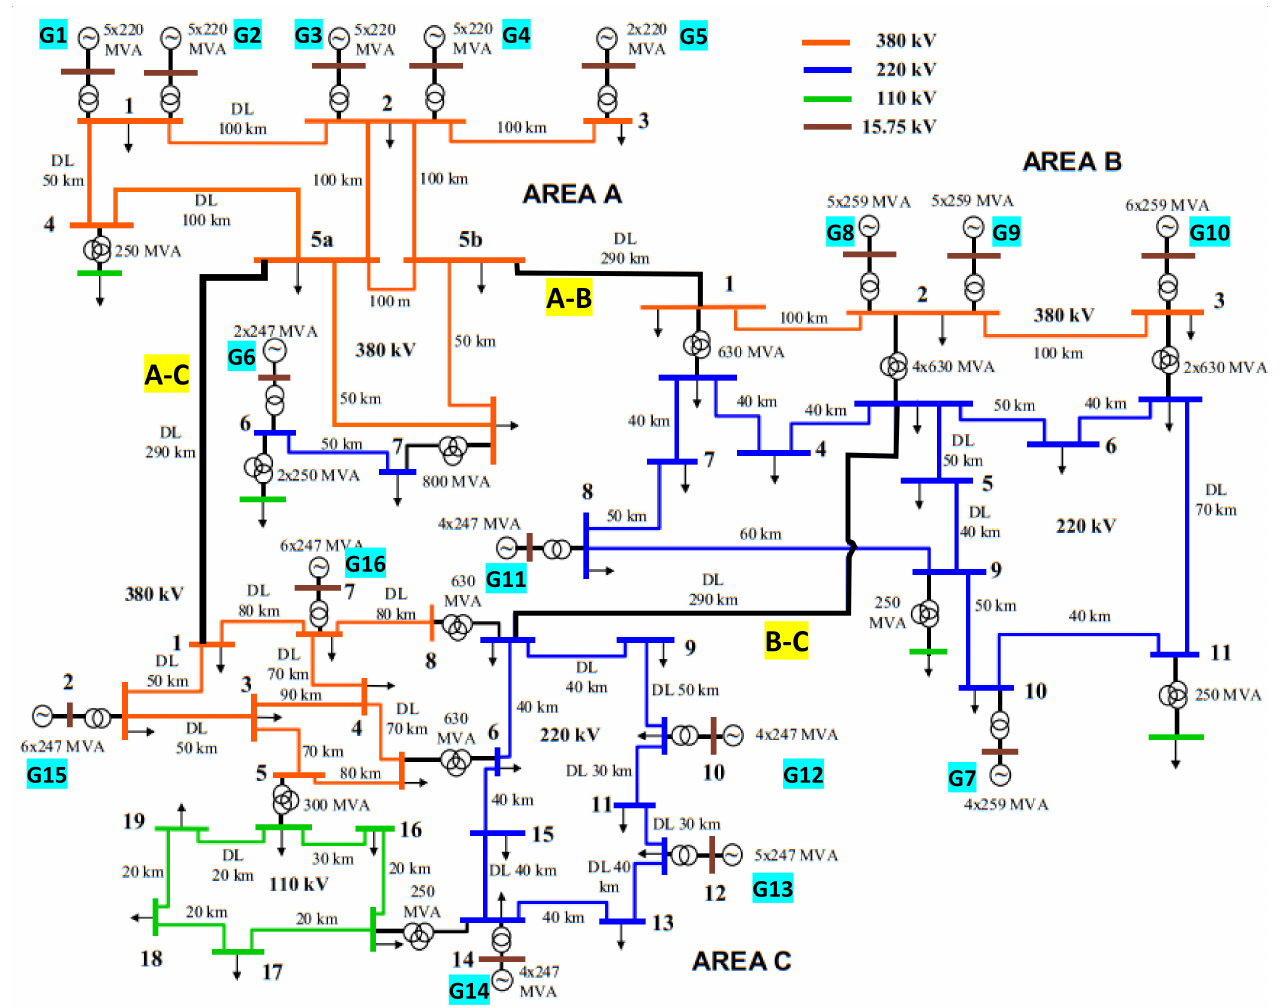
Figure 5. The PST 16-machine test system